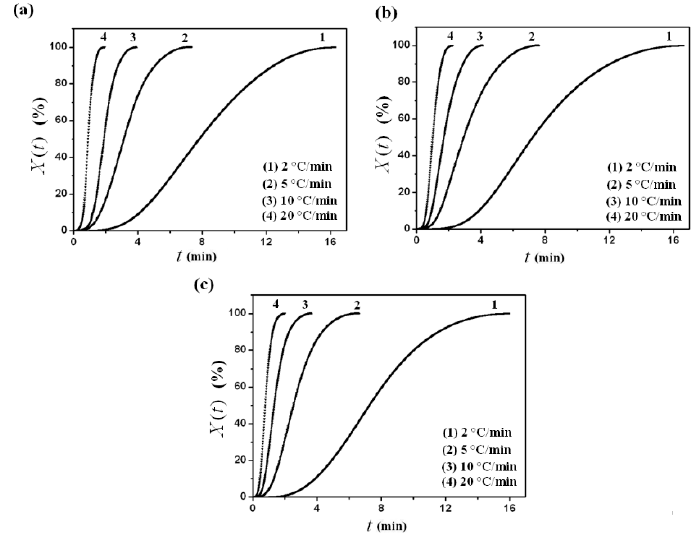
Figure 3. Relative crystallinity, X ( t ) , versus crystallization time, t , for ( a ) PVDF / DMP, ( b ) PVDF / DEP and ( c ) PVDF / DBP.